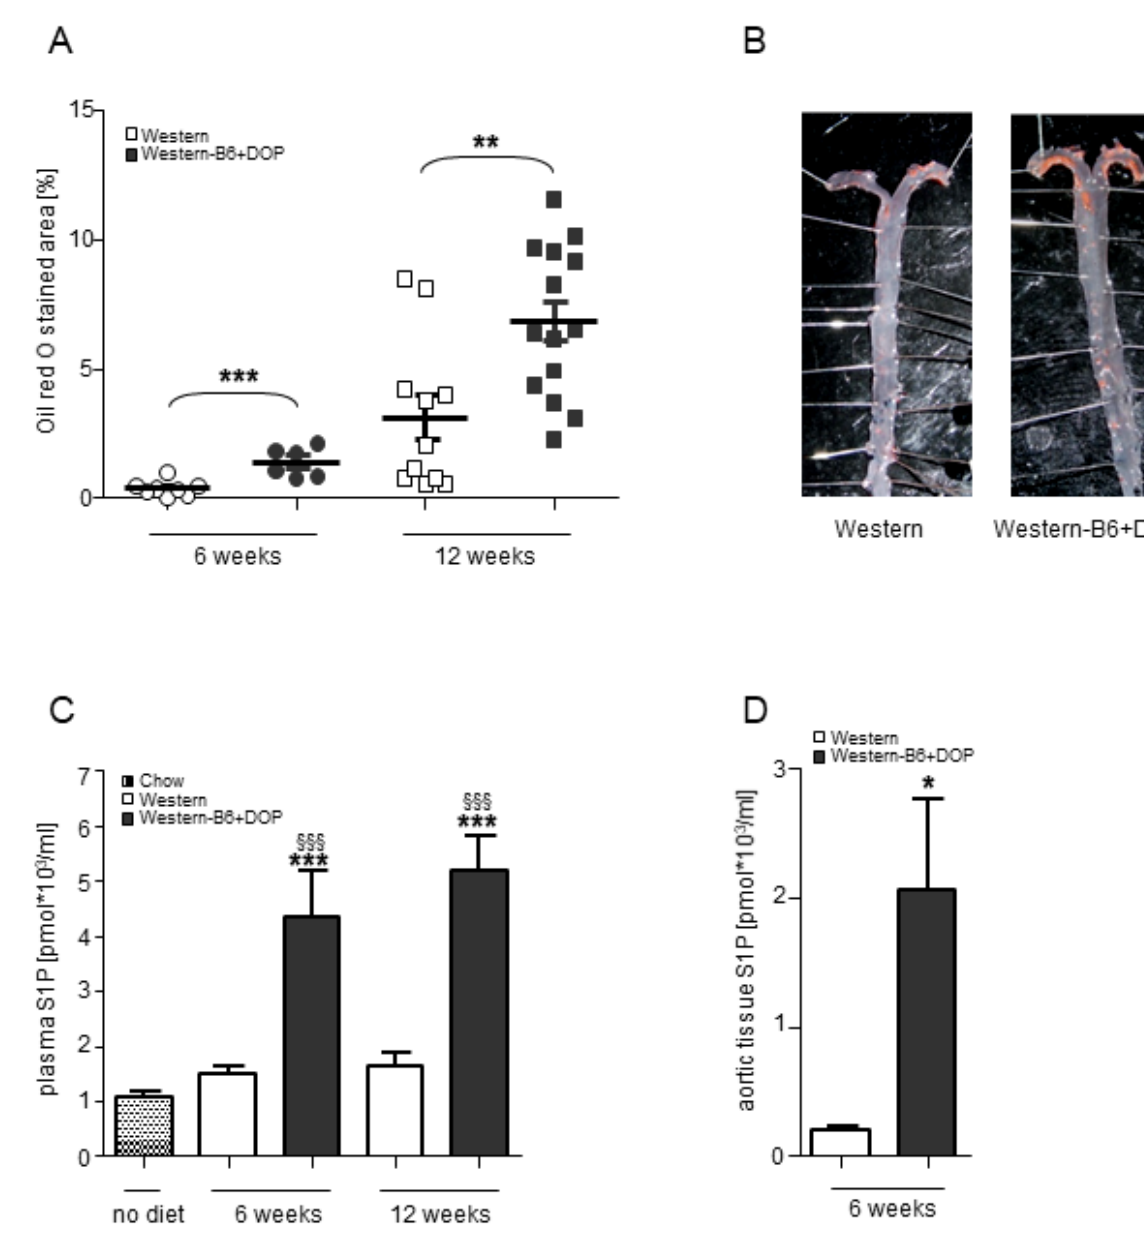
Figure 1. Aggravated atherosclerotic lesion development in cholesterol-fed ApoE − / − mice after pharmacological inhibition of the S1P lyase. ApoE − / − mice were fed Western diet or Western diet without vitamin B6 with or without DOP. ( A ) Quantification of lipid accumulation in the aortae after 6 and 12 weeks of DOP treatment as measured by en face staining with Oil Red O. Results are shown as mean ± SEM. Statistically significant differences were tested for using a one-way ANOVA followed by Tukey’s post hoc analysis; ** p < 0.01; *** p < 0.001. ( B ) Representative en face stainings of aortae after 12 weeks of DOP treatment. ( C ) Plasma S1P levels in all groups as determined by liquid chromatography coupled to tandem mass spectrometry (n = 9–20 animals per group). Results are shown as mean ± SEM. Statistically significant differences from controls were analyzed by one- way ANOVA followed by Tukey’s post hoc analysis; *** p < 0.001 (DOP versus ApoE-Western and ApoE-Western-B6) and §§§ p < 0.001 (versus ApoE − / − on chow diet). ( D ) S1P concentrations in aortic tissue of mice with no Western versus Western-B6+DOP diet for 6 weeks (n = 6 and n = 7). Results are shown as mean ± SEM. Statistically significant differences from controls were analyzed by Student’s t -test; * p <